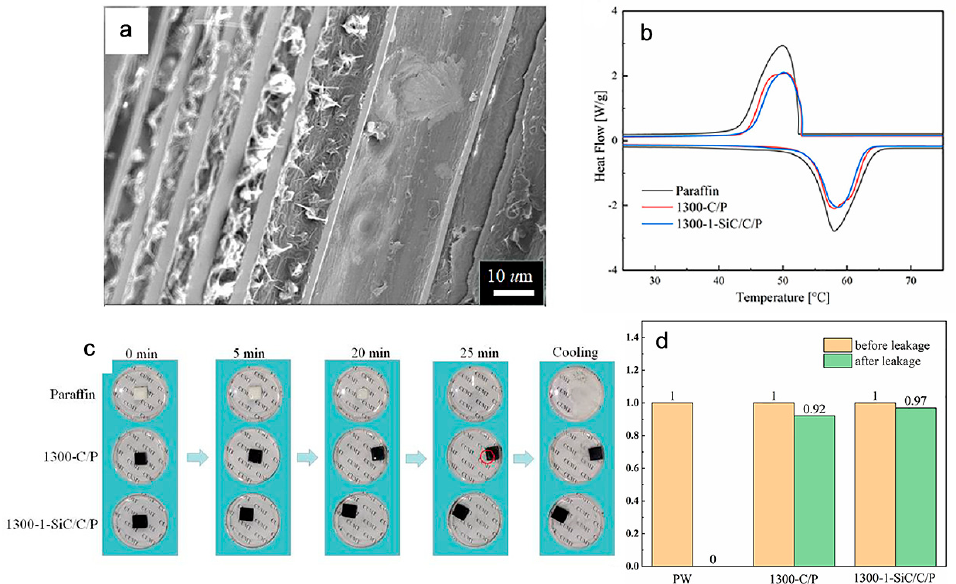
Figure 6. ( a ) SEM micrometer image of SiC/PCCs displaying filling of PW in the microchannels of the carbon skeleton; ( b ) differential scanning calorimetric curves of PW and two different samples of PCC; ( c ) photographs of leakage tests of PW and PCCs upon heating at 80 °C, red circle showing a slight leakage of the sample and ( d ) pictorial representation of weight loss of PCC samples before and after conducting leakage test. Note: SiC = silicon carbide, PW = paraffin wax, PCCs = phase change composites. Adopted with permission from reference [42], copyright 2022, Elsevier B.V.